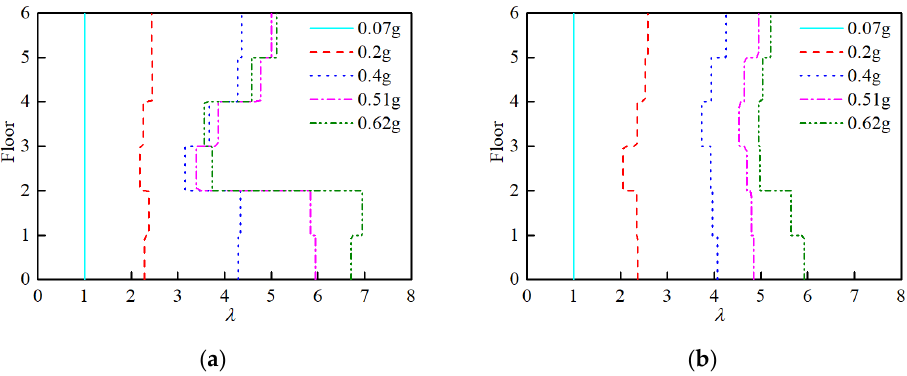
Figure 6. The 𝜆 of each floor at the moment of maximum base shear: ( a ) Along the slope direction; ( b ) Across the slope direction.